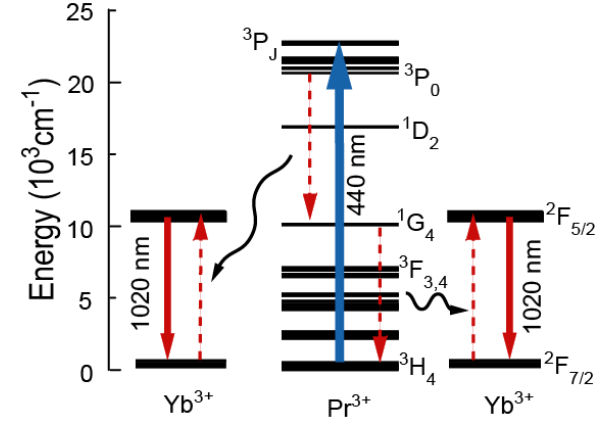
Figure 6. Schematic diagram of quantum cutting between Pr 3+ and Yb 3+